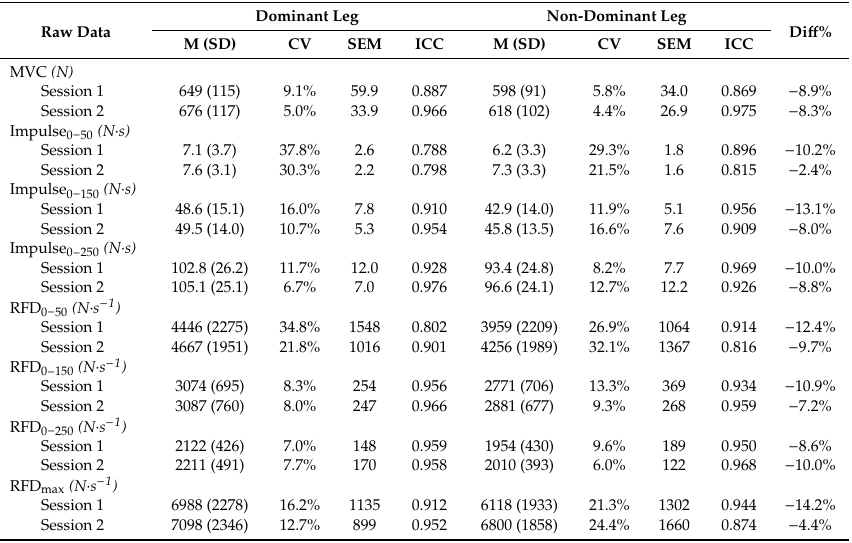
Table 1. Intra-session reliability in maximal voluntary contraction force (MVC), impulse, and rate of force development (RFD) variables for original data (raw).